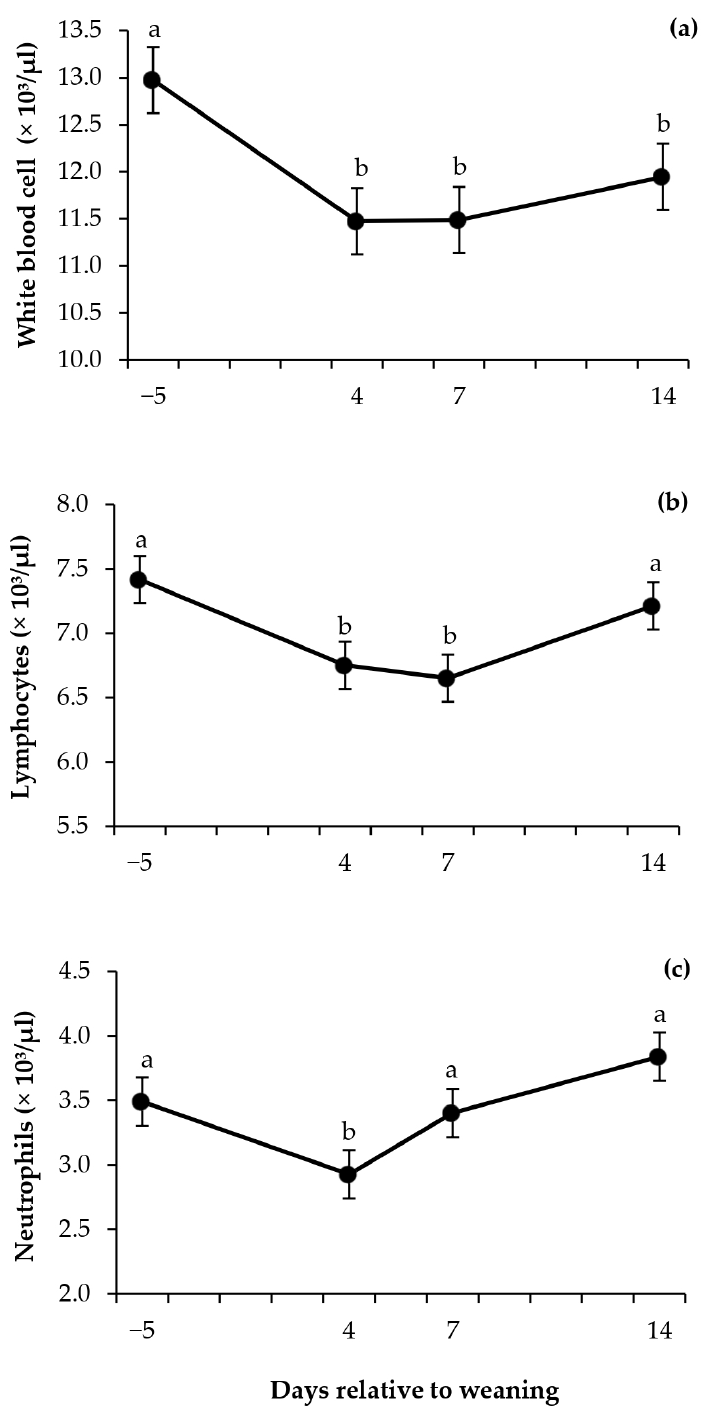
Figure 5. White blood cell number (WBC; ( a )), lymphocyte number ( b ), and neutrophil number ( c ) in Nellore cows with different parity under grazing according to the days relative to weaning. Days with different superscripts differ from each other for all parity orders ( p <